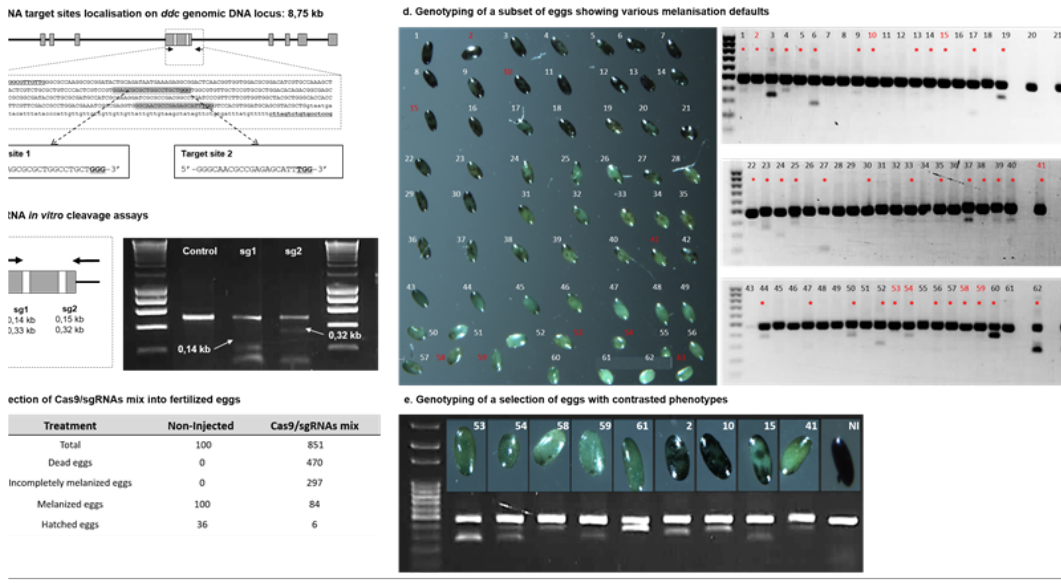
Figure 7 – CRISPR-Cas9 editing of ddc gene and phenotypic defaults observed in injected fertilized eggs. a) The ddc coding sequence comprises 9 exons that are spread over a 8,75 kb genomic DNA region. Single guide RNAs were defined to target two regions (target site 1 and 2) within the 5th exon of the gene. On the 5th exon sequence are underlined the Forward and Reverse primers used to amplify the corresponding genomic DNA. b) In vitro cleavage assay were performed by mixing each sgRNA, the cas9 protein and the PCR product of the 5th exon. The sizes of the expected cleavage products are indicated with white arrows. c) This table compiles the results from the micro- injection within fertilized eggs of a sg1/sg2/Cas9 mix in terms of dead eggs, melanised eggs but also eggs with incomplete melanisation. Post-diapause hatching rates are also indicated, including the non-injected control eggs. d) 63 eggs with melanisation defaults were collected and their ddc genomic location was amplified. Gel electrophoresis analysis reveals the presence of extra bands that are the product of the combined action of the two sgRNAs and confirms the efficiency of genome editing (red stars). e) A focus on nine mutated eggs and one non-injected egg confirms the efficiency of CRISR-Cas9 system to generate contrasted melanisation